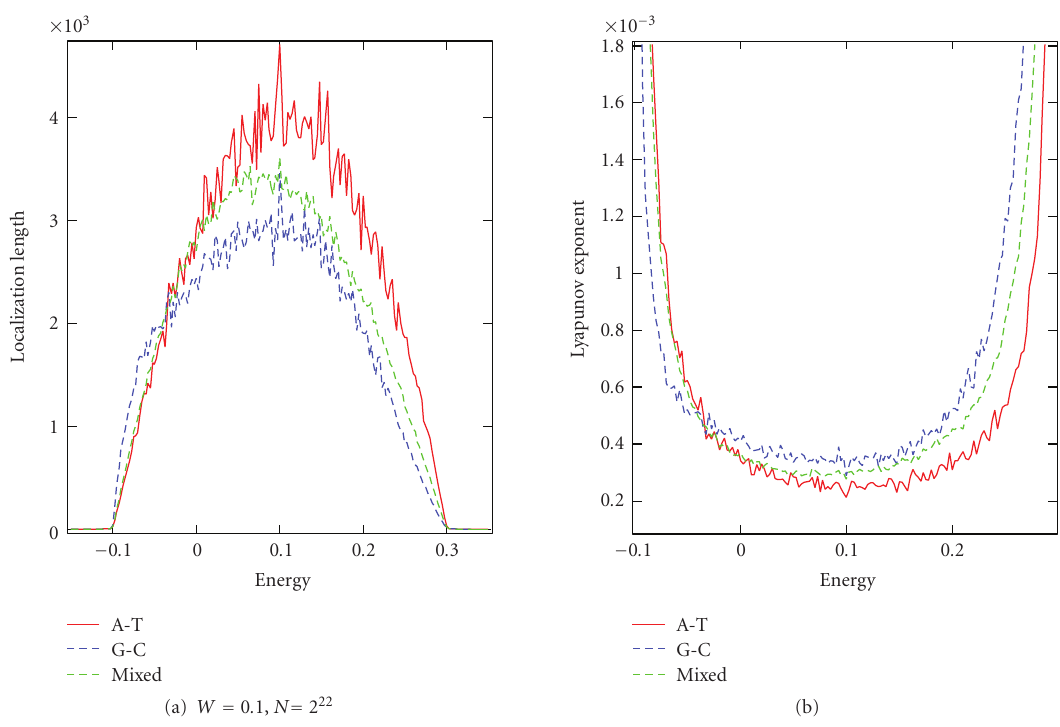
Figure 5: Comparison: (a) localization length and (b) the Lyapunov exponent in poly(dG)-poly(dC), poly(dA)-poly(dT), and the mixed DNA polymers. W = 0 . 1, θ 0 = 36 ◦ , and N = 2 22 .